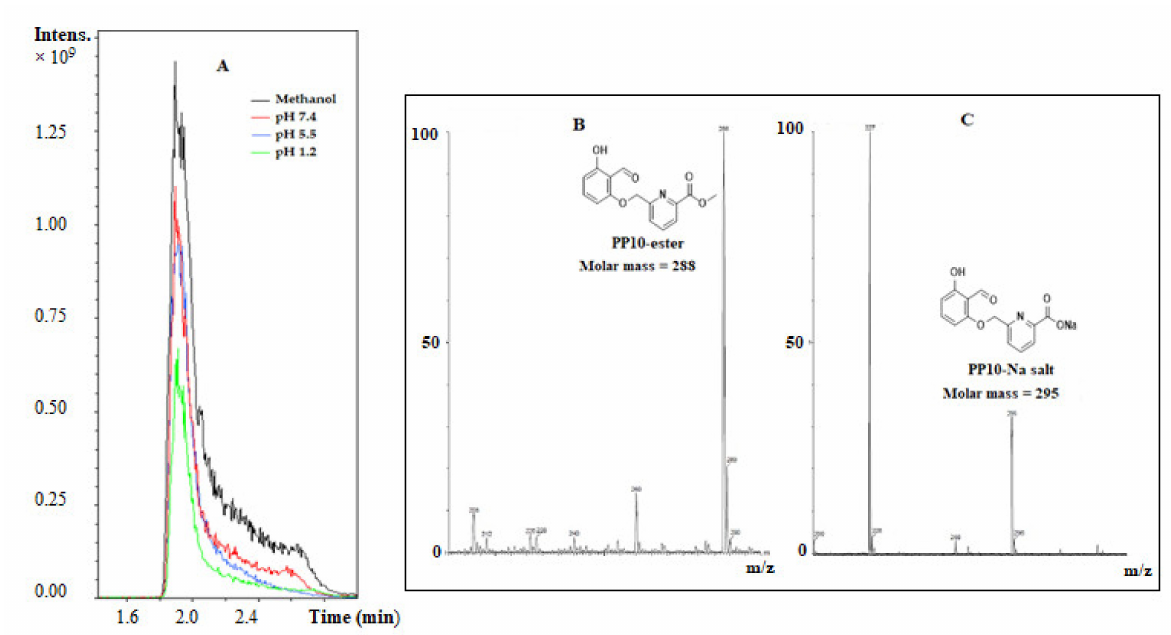
Figure 1. HPLC chromatogram for PP10 in methanol and at different pHs ( A ), and LC-MS for PPP10 ( B ) and the PP10-acid metabolite ( C